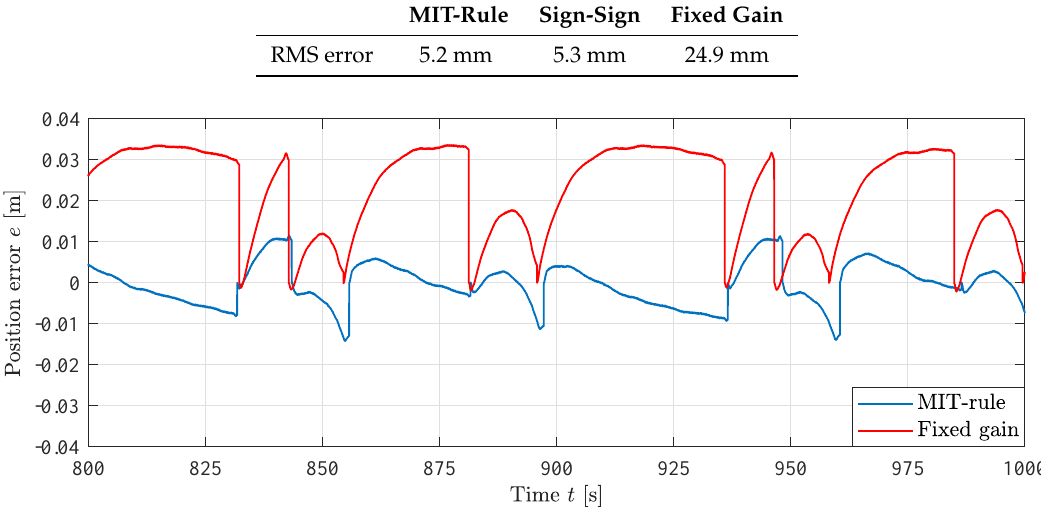
Figure 27. Position error with fixed and adaptive